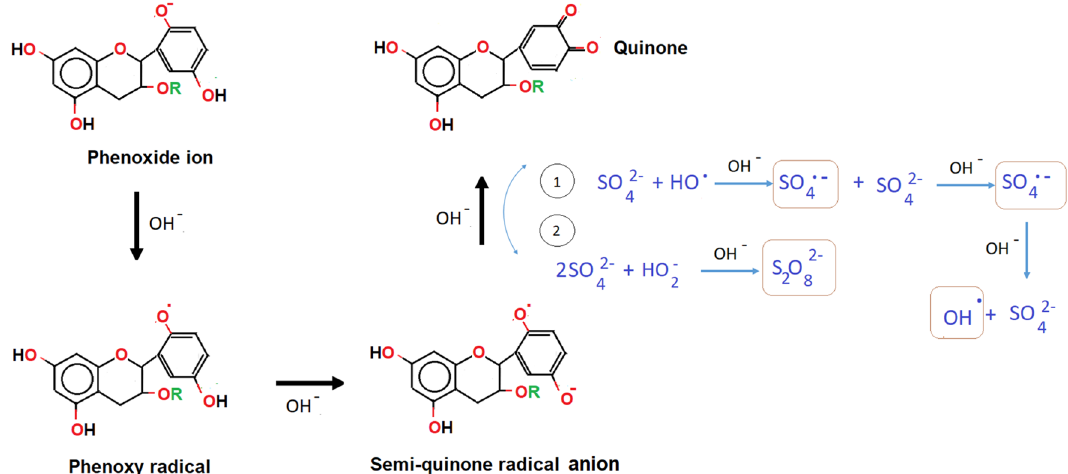
Figure 3. Schematic illustration of the reaction mechanism of phenolic TA from phenoxide ion form to quinone in the presence of sulfate anion from the CuSO 4 precursor used in the reaction.